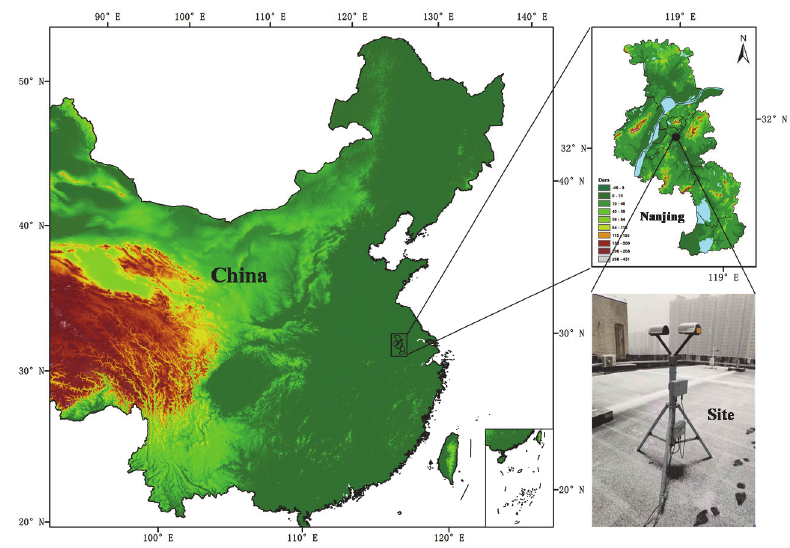
Figure 1. The geographical position of the PARSIVEL disdrometer used in this study. Table 1. The precipitation days selected in this study. The corresponding ground temperature and precipitation time are also shown. The time used here is Beijing time, which is 8 h earlier than UTC.